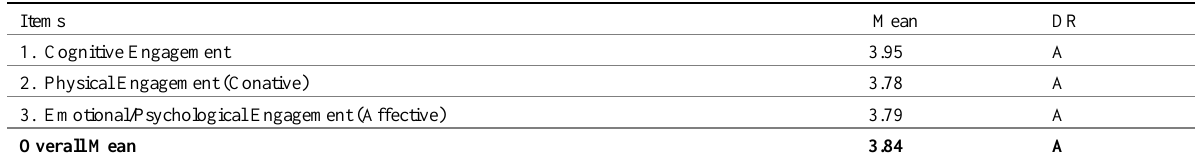
Table 11: Summary of Work Engagement of Employees of Divine Word Colleges in the Ilocos Region